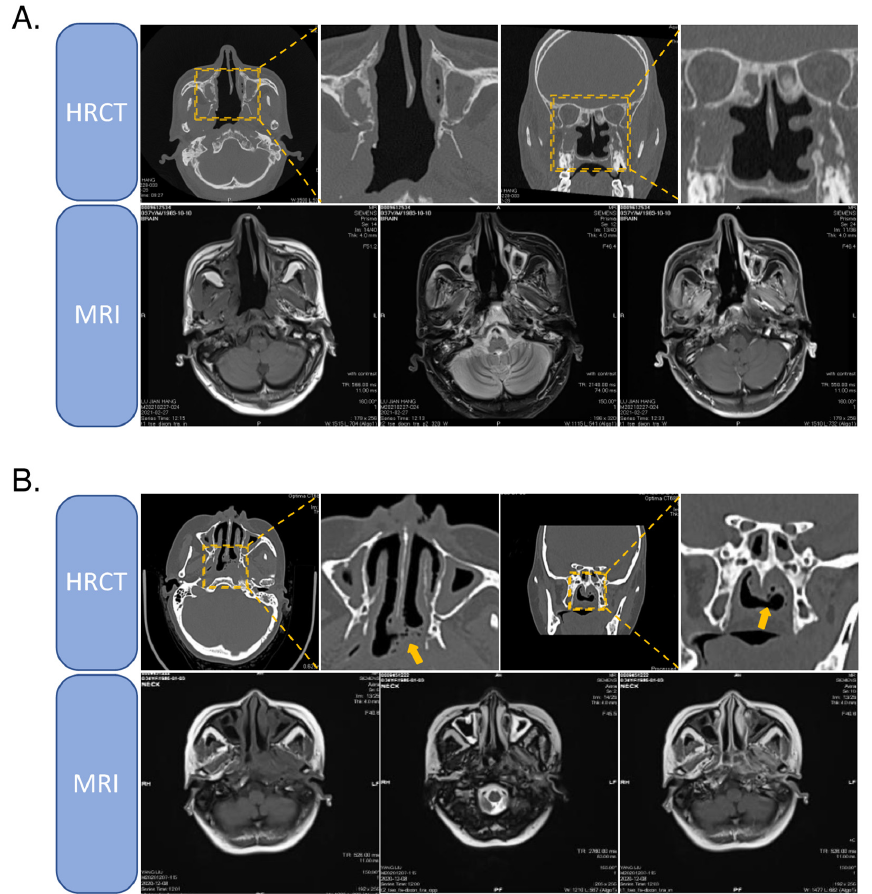
Figure 2. ( A ) HRCT and MRI images of bone necrosis in recurrent NPC patients. ( B ) HRCT and MRI images of soft tissue necrosis in recurrent NPC patients. An “air bubble shadow” can be seen in the soft tissue shadow on CT.